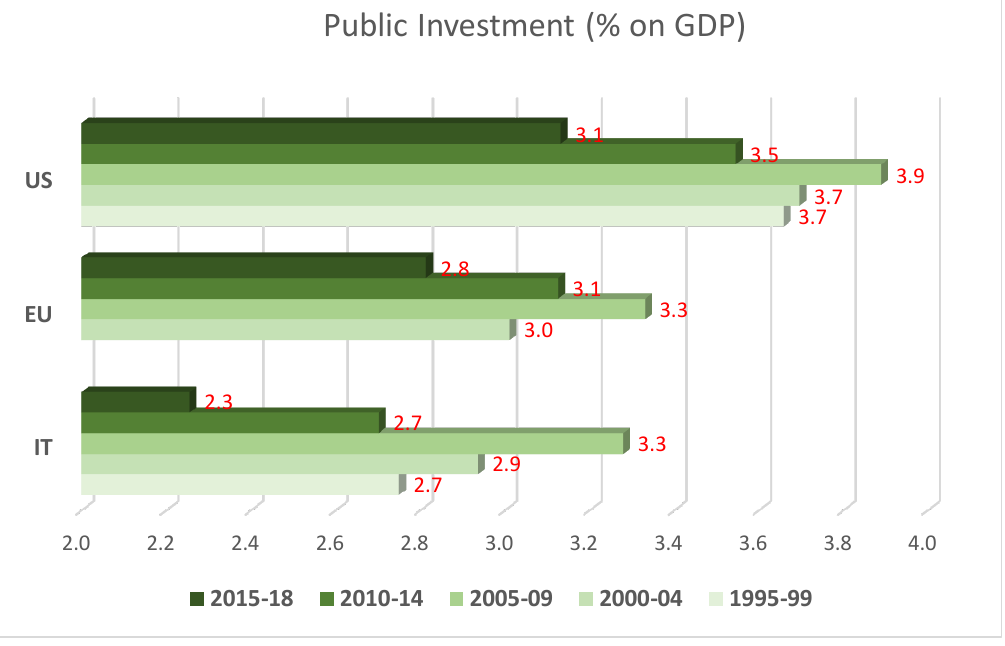
Source: Elaborations on OECD